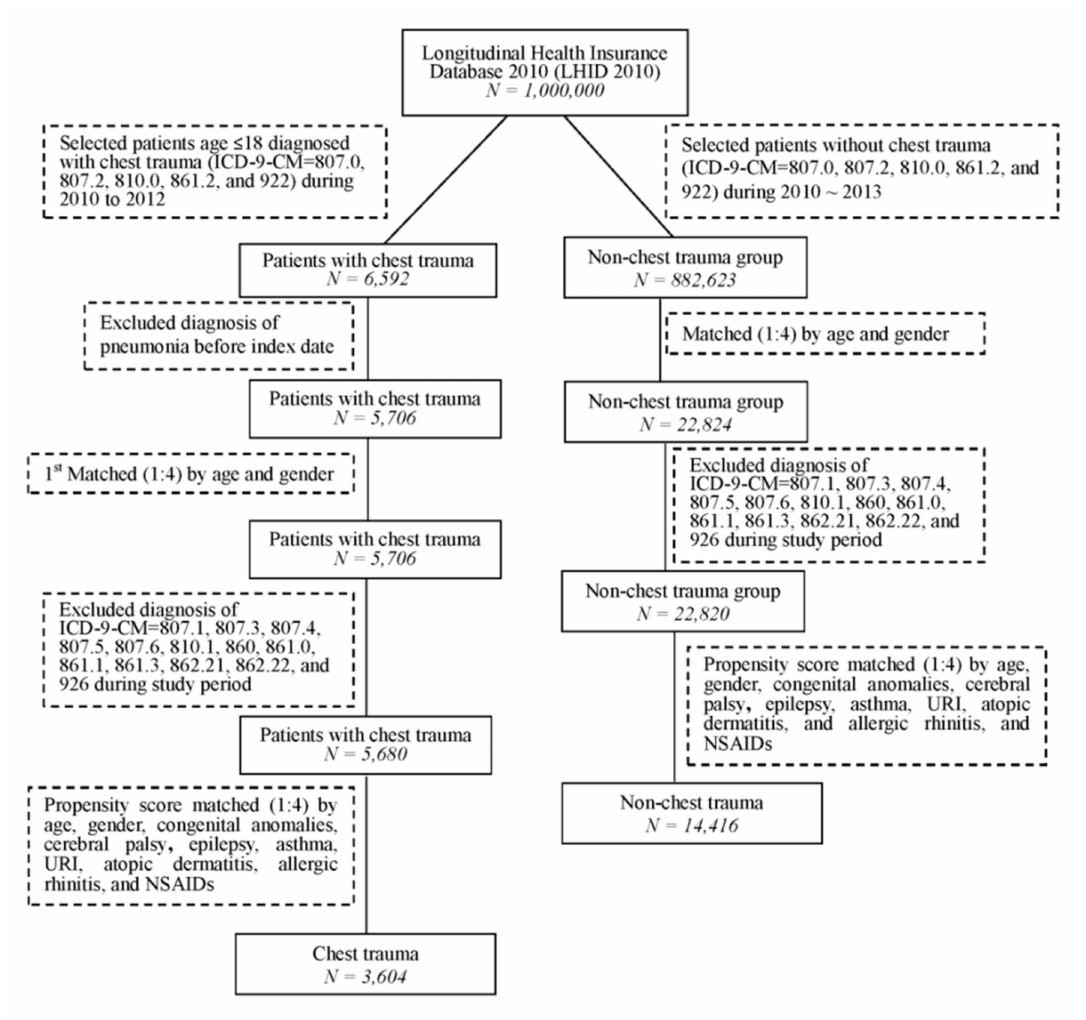
Figure 1. Flowchart for patient